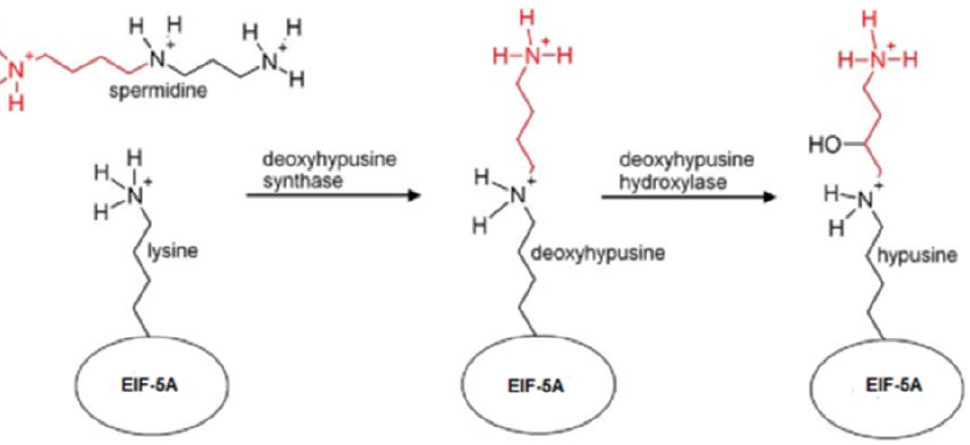
Figure 1. Hypusine is formed within two subsequent steps. The first step is catalysed by deoxyhypusine synthase which transfers an aminobutyl moiety from the triamine spermidine to eukaryotic initiation factor 5A in a NAD + 2 dependent reaction. Hypusine biosynthesis is completed by the hydroxylation of the side chain by deoxyhypusine hydroxylase.